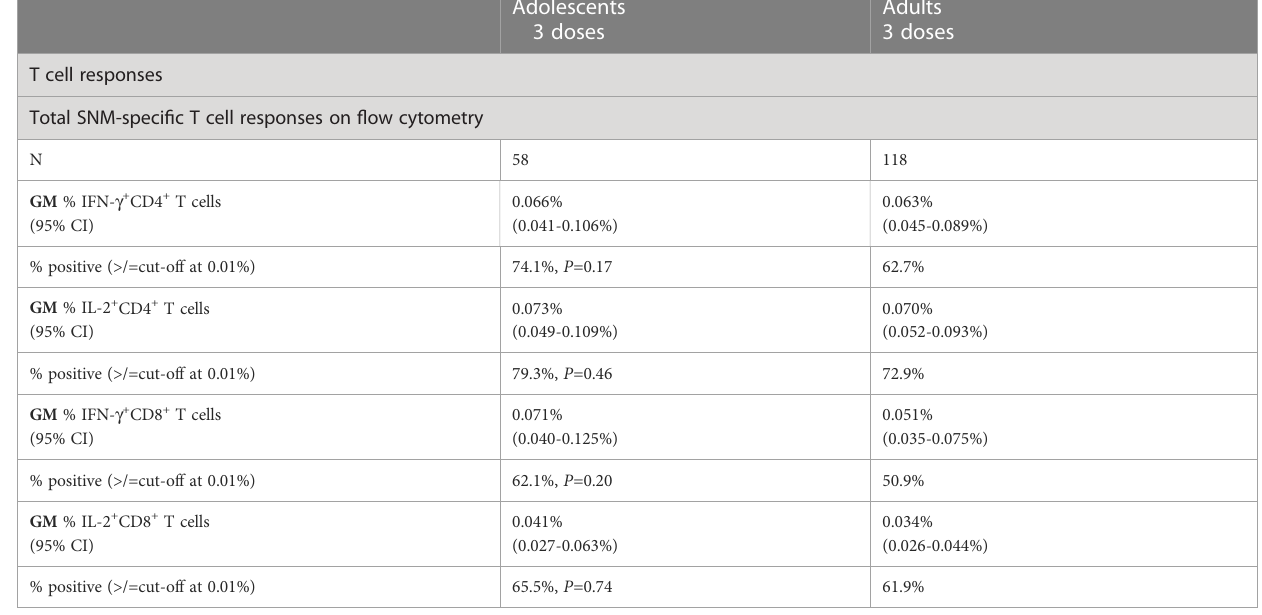
TABLE 2 Cellular immunogenicity outcomes against wild-type SARS-CoV-2 after the third dose of CoronaVac in evaluable analysis population.